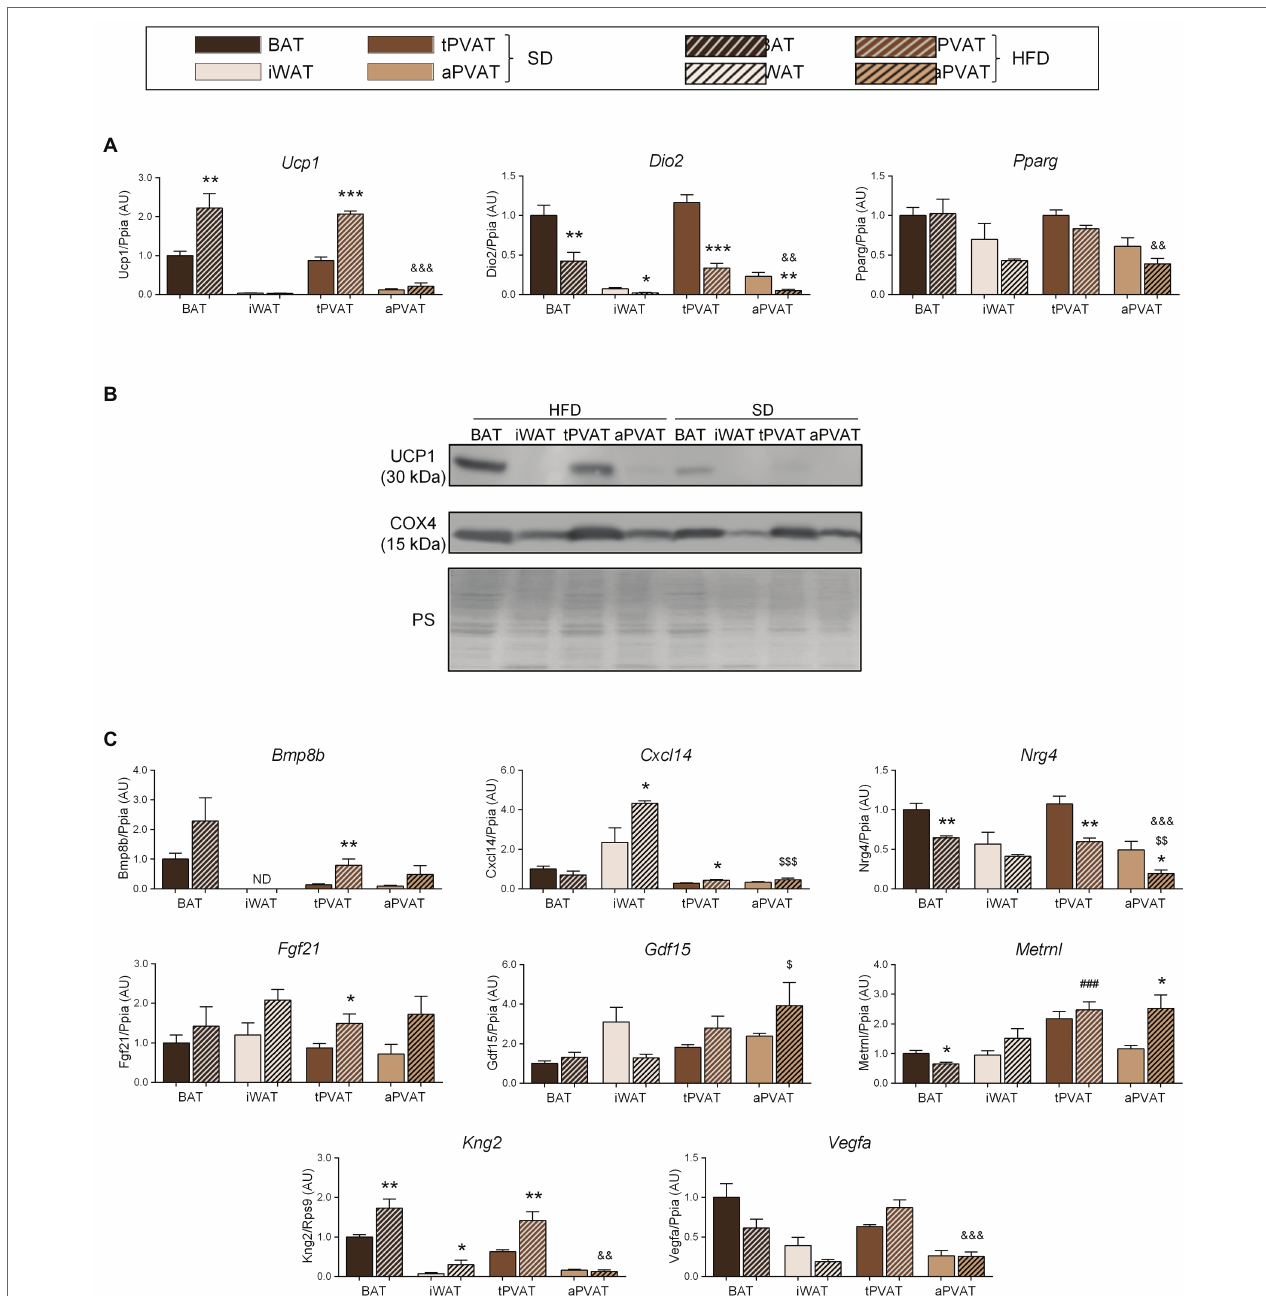
FIGURE 3 | Effect of HFD feeding for 1 month on perivascular adipose depots in mice. (A) Relative transcript levels of genes encoding components of the thermogenic and adipogenic machinery. (B) Representative immunoblots of UCP1 and COX4 proteins. (C) Relative transcript levels of batokine-encoding genes. Bars correspond to means ± SEM from 5 to 6 mice. Significant differences (* p < 0.05, ** p < 0.01, and *** p < 0.001) are shown for HFD feeding effect at each adipose depot. Comparison among depots in the HFD-fed condition is shown for BAT vs. tPVAT ( ### p < 0.001), iWAT vs. aPVAT ( $$ p < 0.01 and $$$ p < 0.001), and tPVAT vs. aPVAT ( && p < 0.01 and &&& p < 0.001). ND,